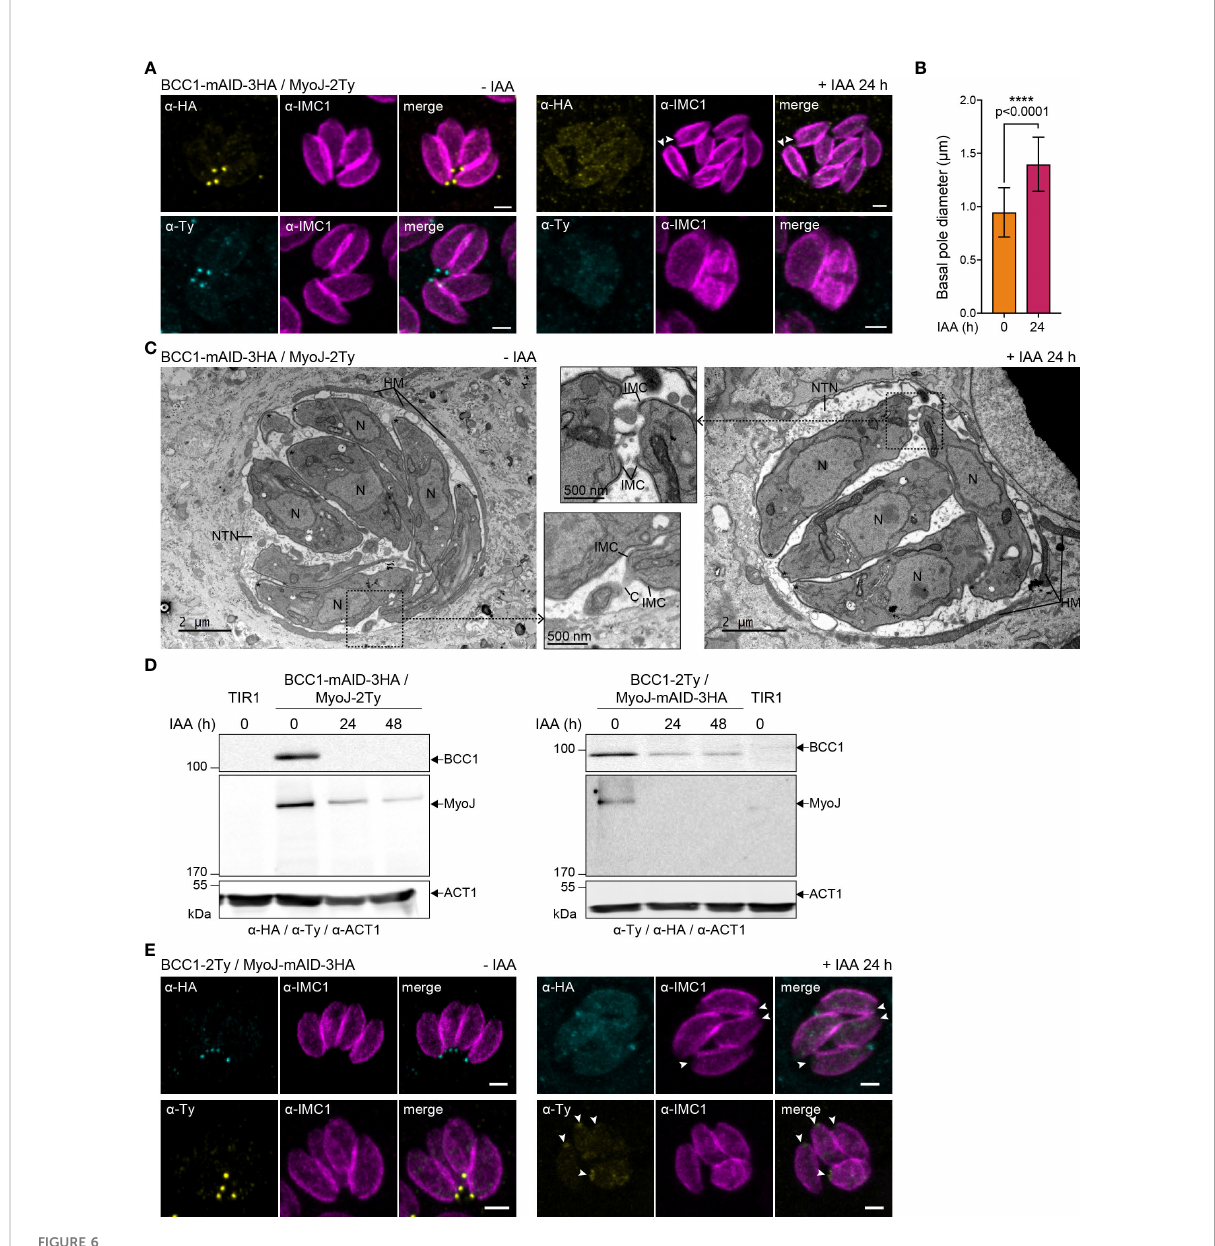
FIGURE 6 BCC1 is involved in the constriction of the basal complex. (A) Localization of endogenously tagged MyoJ (MyoJ-2Ty) in the auxin-inducible knockdown of BCC1 (BCC1-mAID-3HA) assessed by immuno fl uorescence (IFA) after a 24 h treatment with or without 500 m M of auxin (IAA). Magenta: IMC1, Yellow: BCC1, Cyan: MyoJ. Scale bars: 2 m m. (B) Diameter of the basal pole of BCC1-mAID-3HA/MyoJ-2Ty tachyzoites ± IAA, measured on IFA pictures using the IMC1 staining. The distance between the basal edges of the IMC has been measured in 53 non-treated and 108 treated parasites. The results are represented as mean ± SD, and their signi fi cance was assessed using an unpaired t-test, with the two- tailed p-value written on the graph. (C) Electron microscopy pictures of BCC1-mAID-3HA cell line non-treated and treated with IAA for 24 h. On the panel in the middle, zoom on the basal pole. Asterisks show the parasites apical pole. C, intracellular connection; HM, host mitochondria; N, nucleus; NTN, nanotubular network. (D) The expression of BCC1-2Ty and MyoJ-2Ty was assessed in the MyoJ-mAID-3HA and BCC1-mAID-3HA cell lines, respectively, after 0, 24, and 48 h of IAA treatment. (E) Localization of endogenously tagged BCC1 (BCC1-2Ty) in the auxin-inducible knockdown of MyoJ (MyoJ-mAID-3HA) assessed by IF after a 24 h treatment with or without 500 m M of IAA. Magenta: IMC1, Yellow: BCC1, Cyan: MyoJ. Scale bars: 2 m